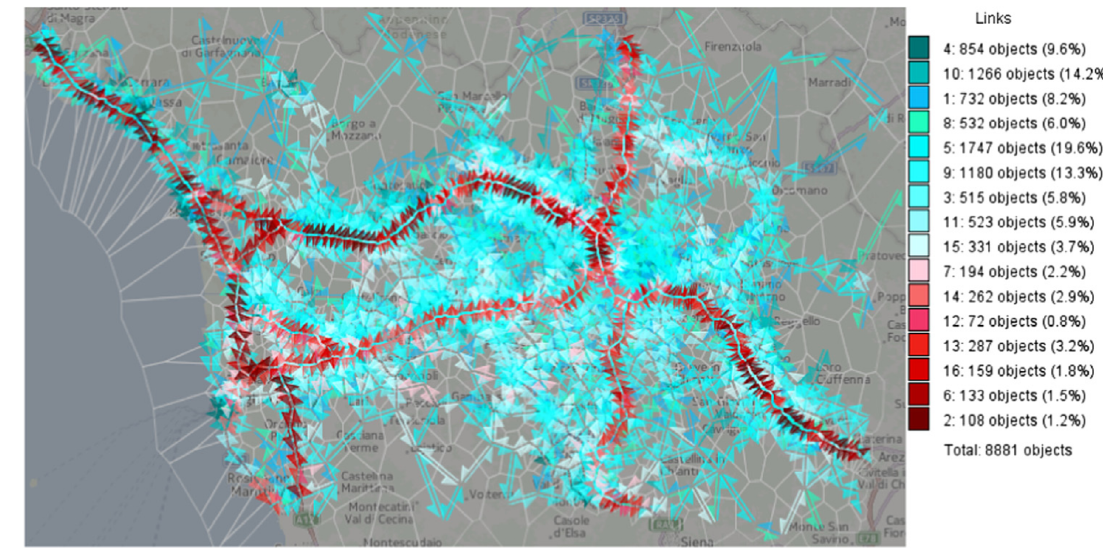
Figure 5. Flow map visualization color-coded in terms of mean speed in road links [36].